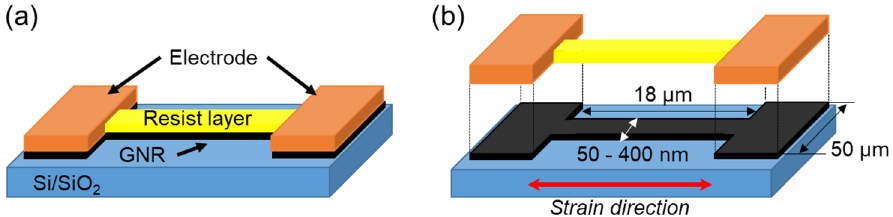
Figure 2. ( a ) Schematic image of the strain gauge in the area-arrayed GNR strain sensor, and ( b ) GNR structure of the strain gauge.